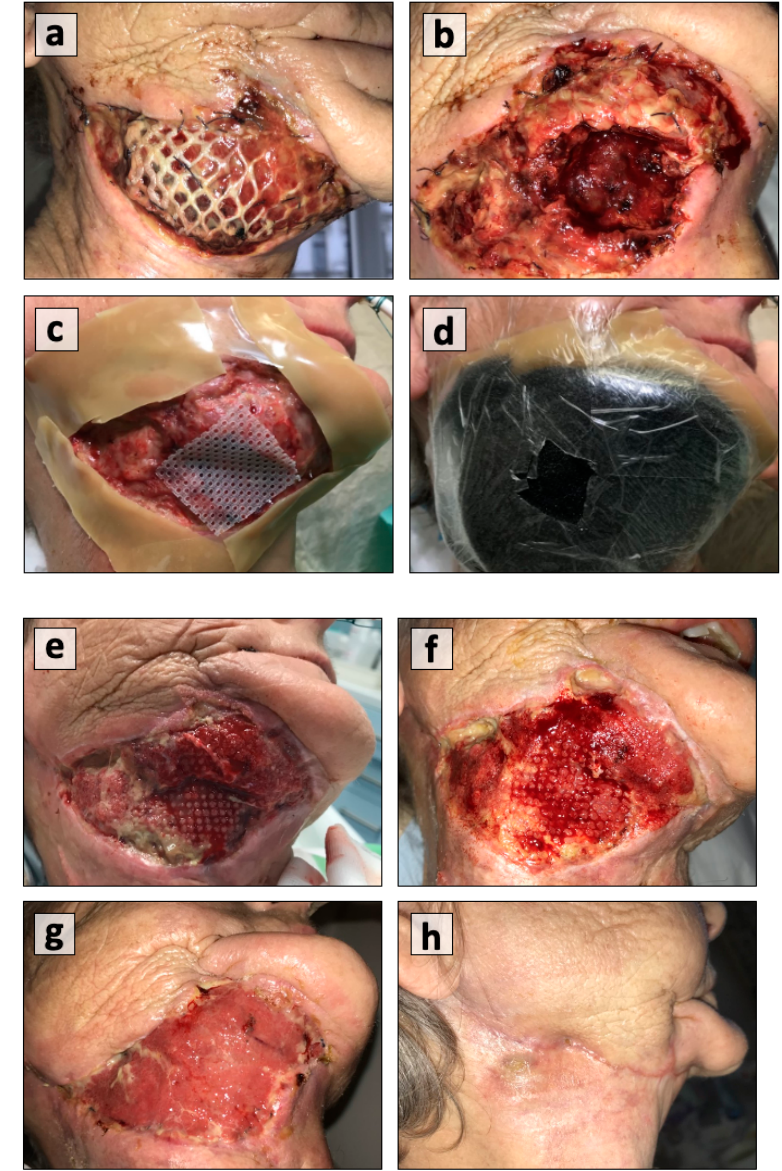
Figure 3. ( a ) Pectoralis major muscle flap coverage for reconstruction plate that developed hematoma and infection; ( b ) evacuation of hematoma and debridement; ( c ) the placement of a hydrocolloid film around the wound margins and a grid to protect the thoracodorsal vessels of the flap; ( d ) the placement of a polyurethane foam dressing with an open pore structure; ( e ) good blood flow and granulation tissue formation after 1st dressing; ( f ) uniform healing at 2nd dressing; ( g ) wound healing at 3rd week; and ( h ) wound healing after 4 months.